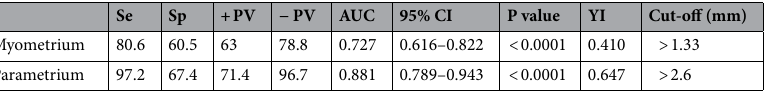
Table 3. The diagnostic accuracy of fv-D in the myometrium and parametrium. AUC = area under the curve, Se = sensitivity, Sp = specificity, + PV = positive predictive value, -PV = negative predictive value, YI = Youden index.